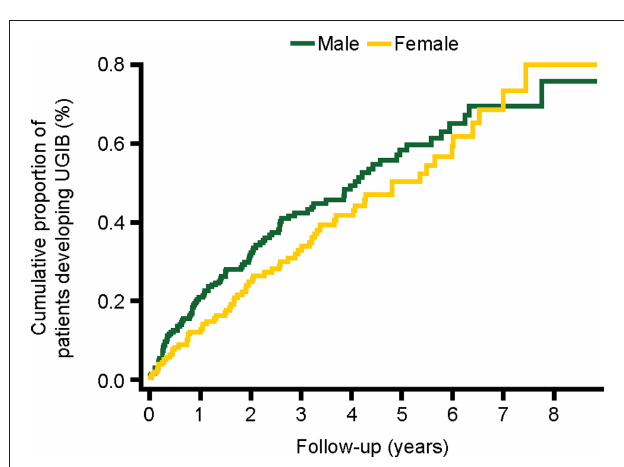
Figure 3 | Cumulative proportion of patients developing ugiB during follow-up. UGIB, upper gastrointestinal bleeding.